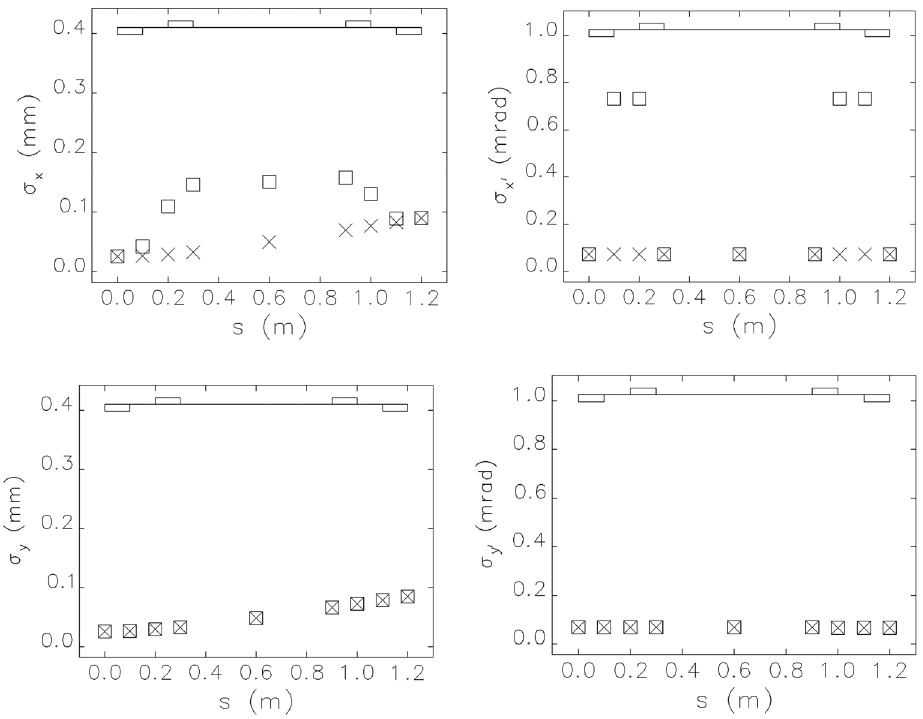
FIG. 17. Top left: rms horizontal beam size along NIEM with (squares) and without (crosses) energy spread. Top right: rms horizontal angular spread in mrad along NIEM with (squares) and without (crosses) energy spread. Bottom left: rms vertical beam size. Bottom right: rms vertical angular